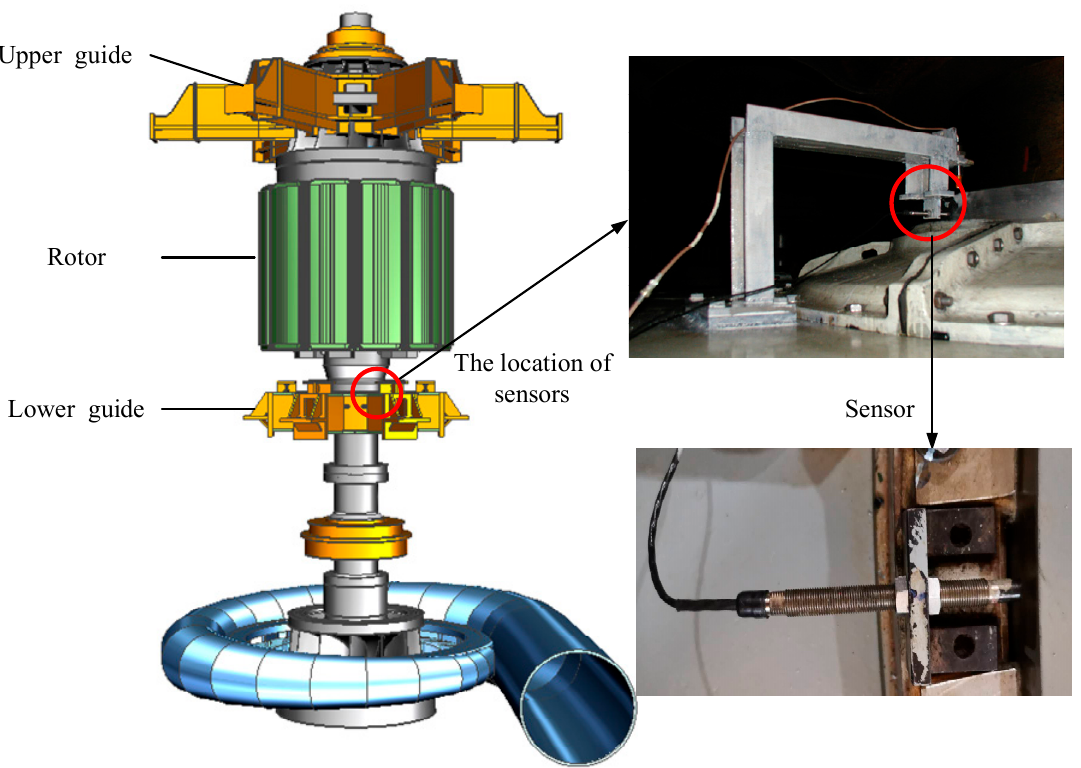
Figure 3. The structure of the hydropower generator unit (HGU) and the location of the sensors.